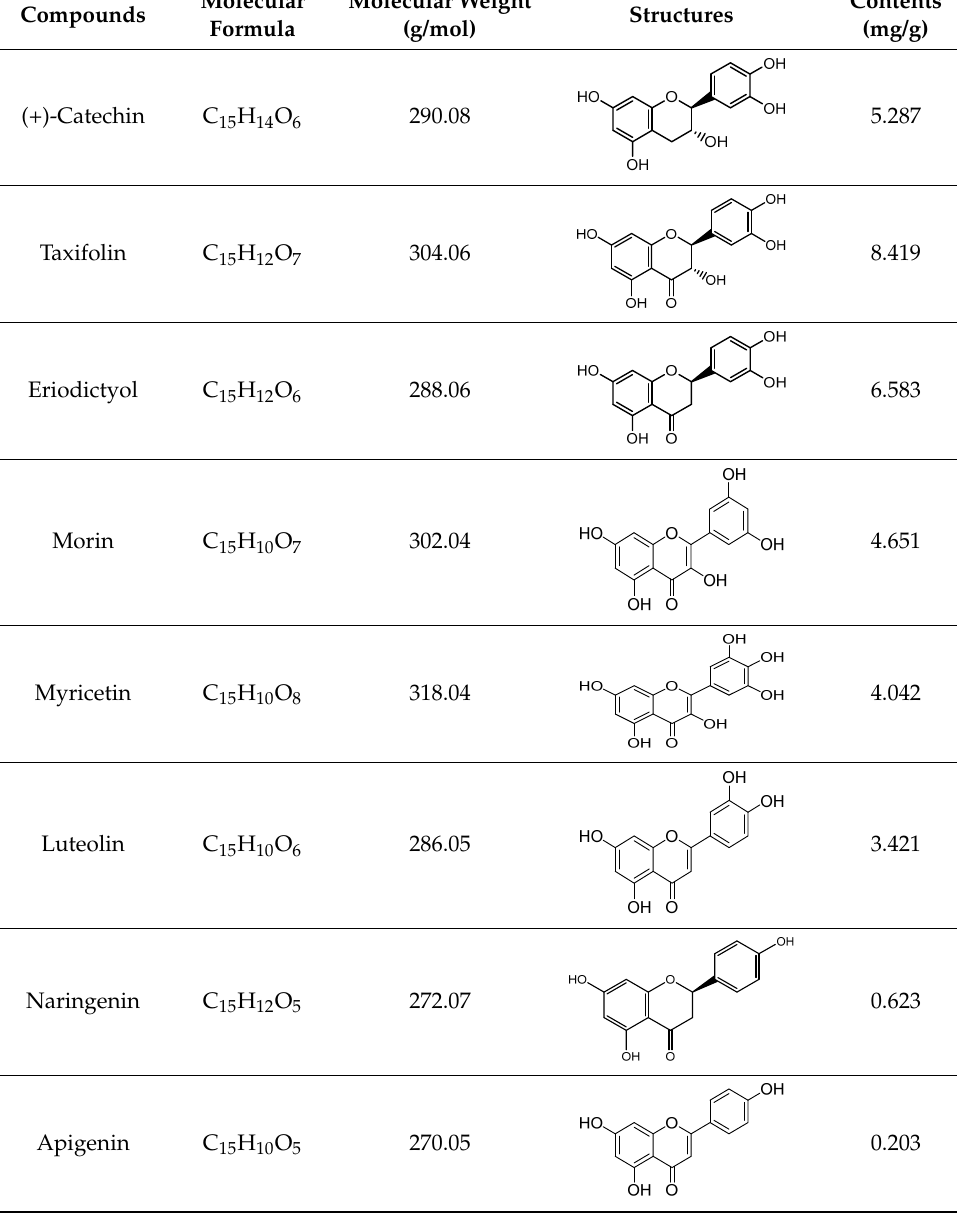
Table 1. Flavonoids identified in TSE.